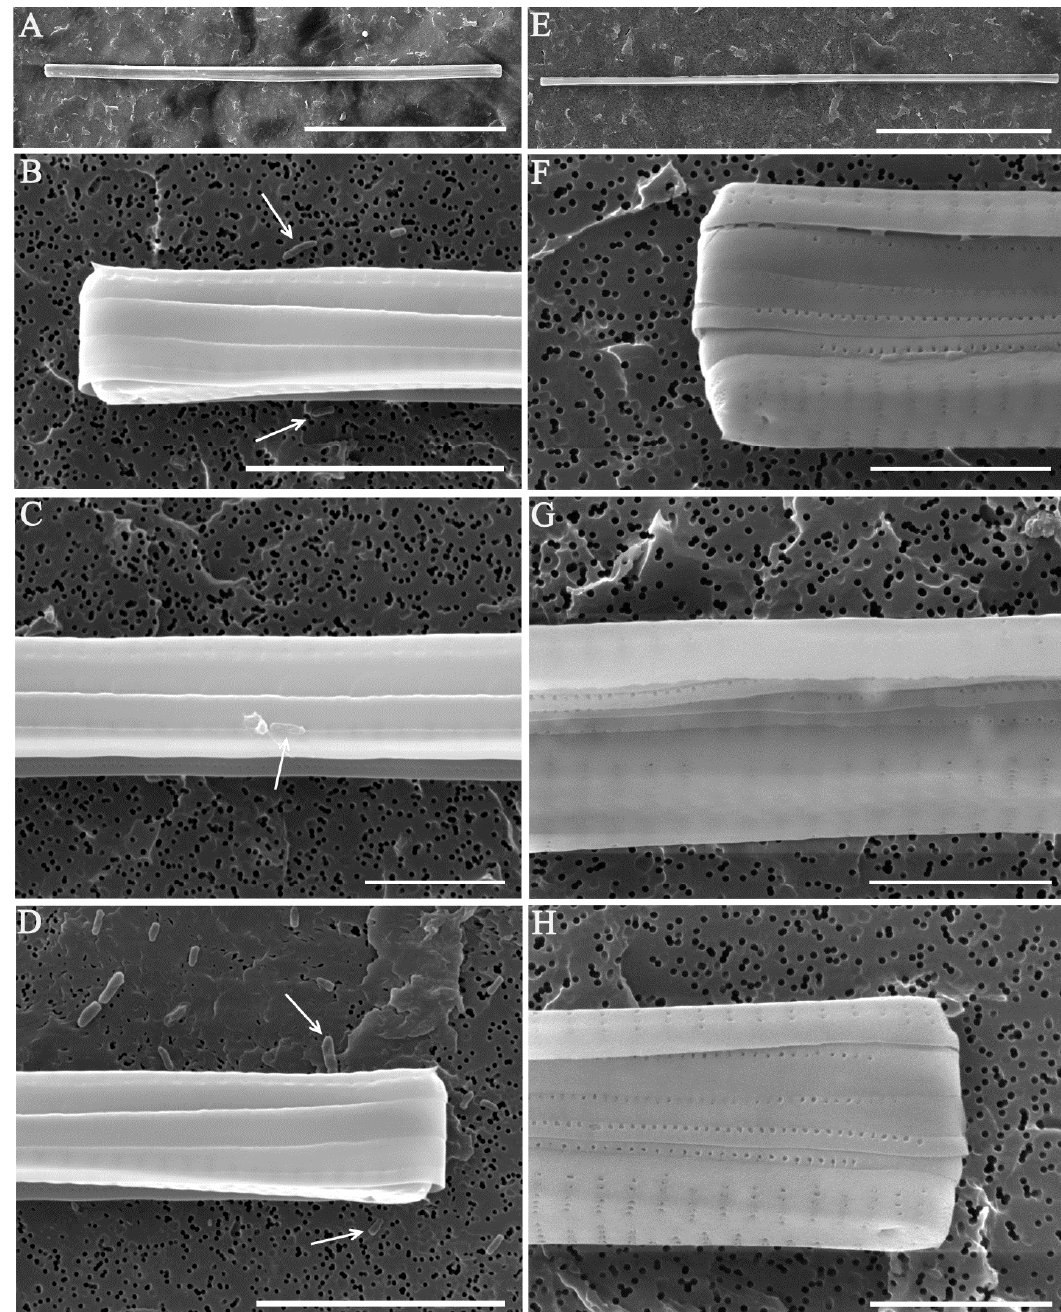
Figure 2. SEM validation of diatom U. danica. ( A – D ) Xenic culture after filtering and washing; bacteria are marked by arrows. ( E – H ) Axenic culture. Scale bars: A, E—100 µ m; B, D—10 µ m; C, F, G, H—5 µ m.